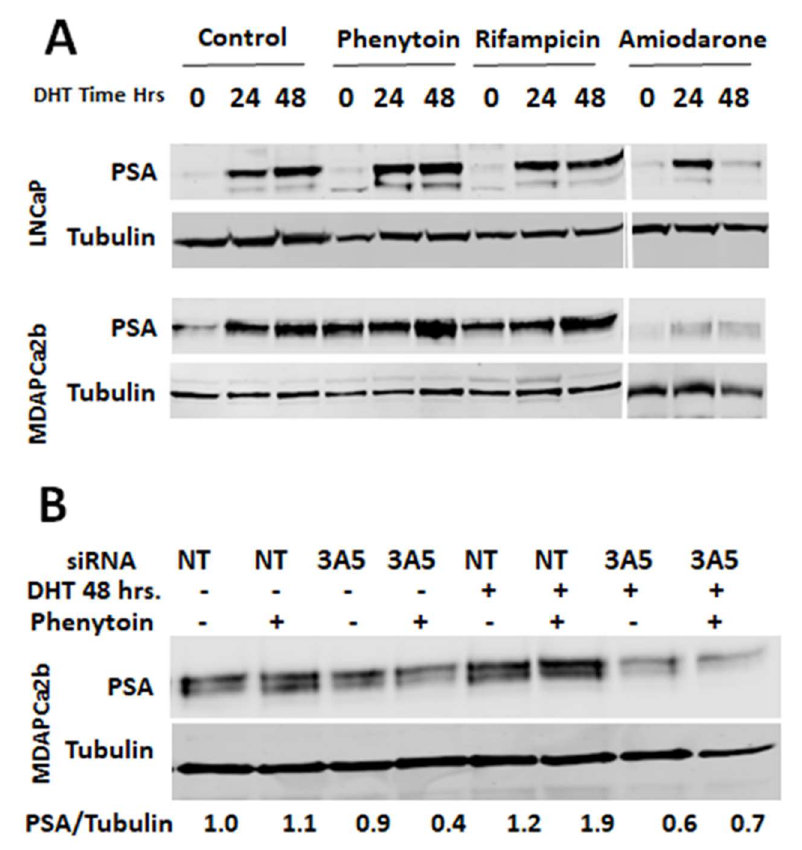
Figure 5. Modulation of PSA expression after CYP3A5 inhibitor / inducer treatment. ( A ) To confirm the effect of CYP3A5 modulating drugs on AR downstream signaling LNCaP and MDAPCa2b cells were treated with Phenytoin (50 µM), Rifampicin (30 µg/mL), and Amiodarone (5 µM) in charcoal stripped serum media followed by 24 or 48 hours of DHT (10nM) treatment. Total cell lysate was used to check PSA production using western analysis. ( B ) To confirm that the effect of CYP3A5 inducer on AR downstream signaling is due to its effect on CYP3A5, the PSA was measured in a CYP3A5 negative background (CYP3A5 siRNA). Cells were treated with non target (NT) or CYP3A5 siRNA